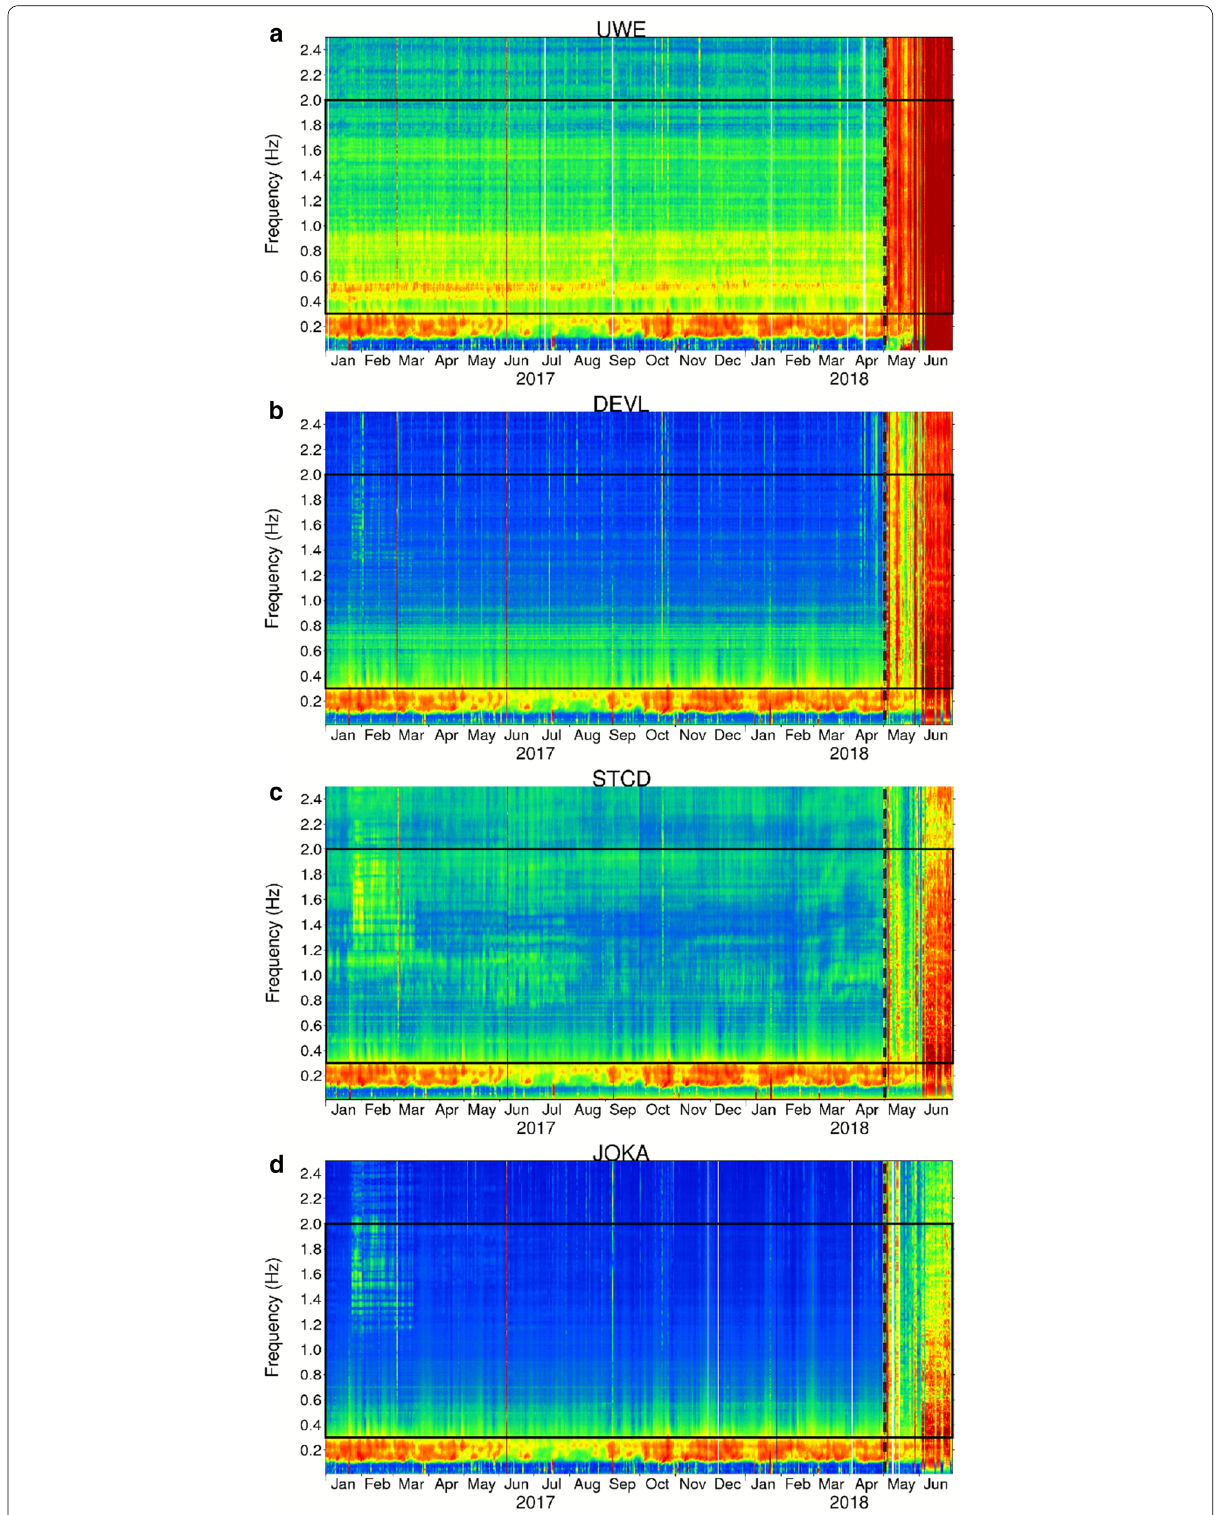
Fig. 2 Amplitude spectrum of raw seismic records for selected stations. a Station UWE. b Station DEVL. c Station STCD. d Station JOKA. Station locations are shown in Fig. 1. Black dashed line indicates the eruption time. Black boxes denote the frequency bands used in the